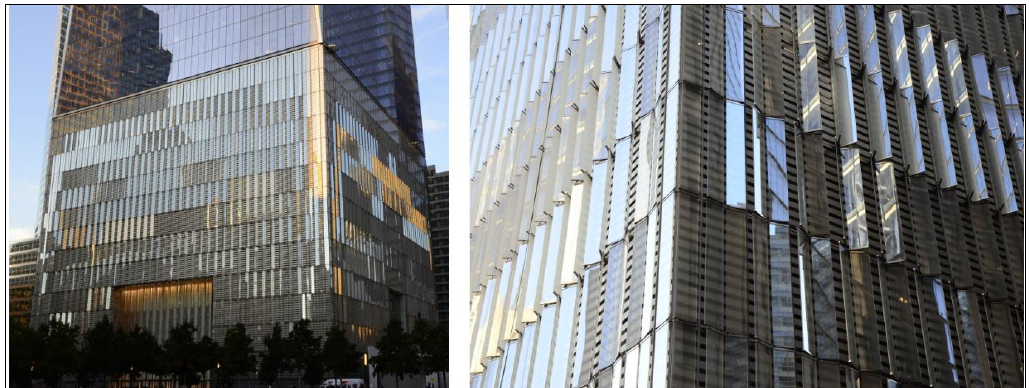
Figure 23. One World Trade Center: Reinforced concrete base with aluminum claddings and glass panels mounted in special profiles (photograph by authors).